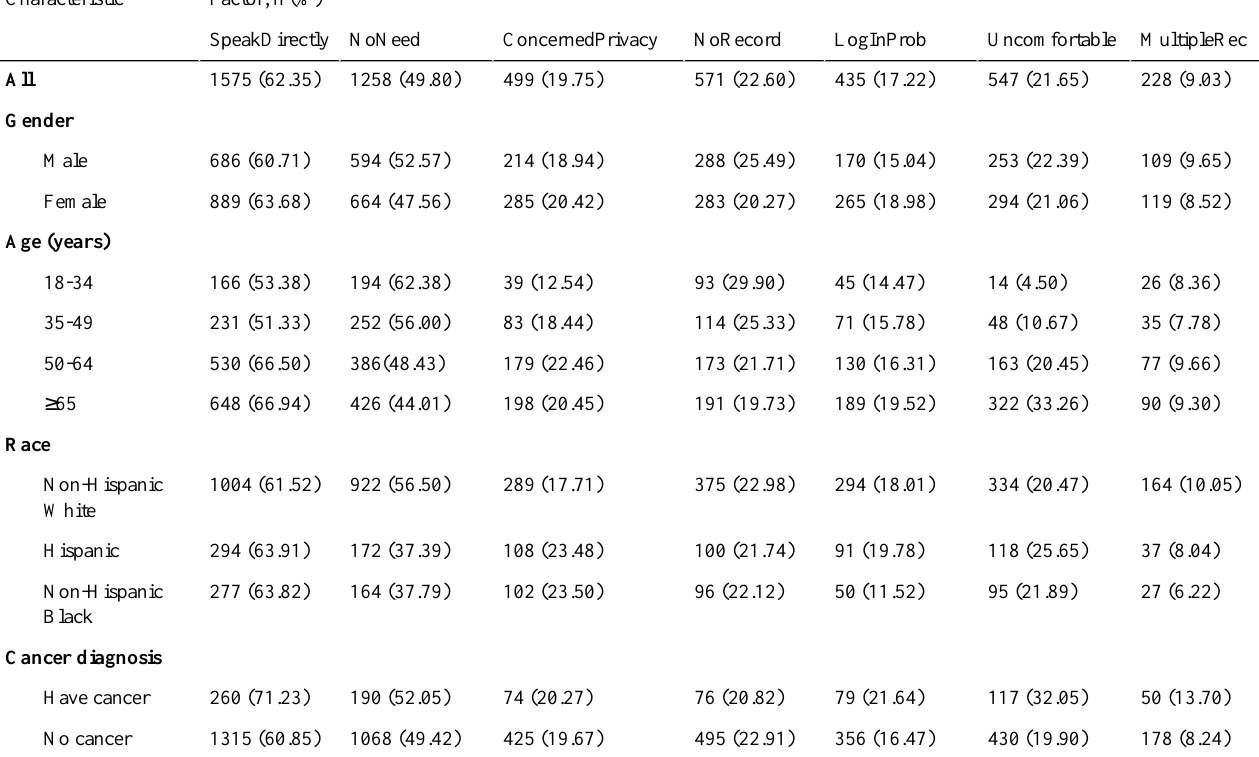
Table 4. Frequencies of reasons that explain nonuse of online medical records. Factor, n